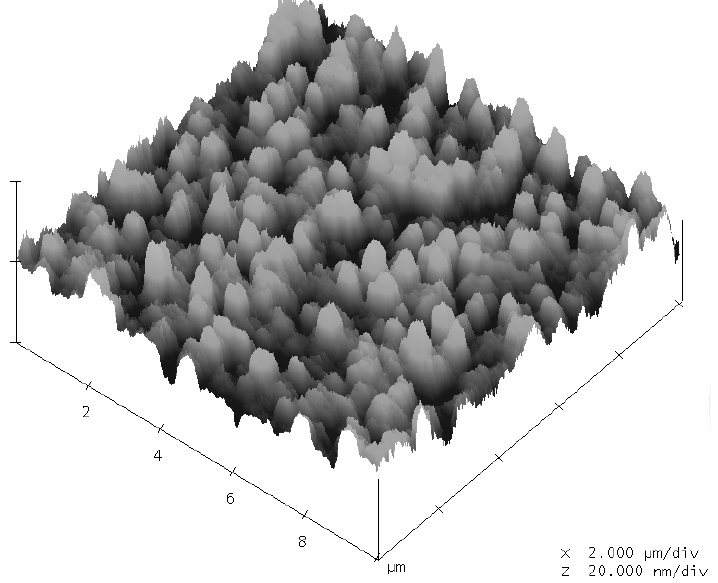
Figure 4. Surface morphology of ruthenium nitride thin films by AFM measurement